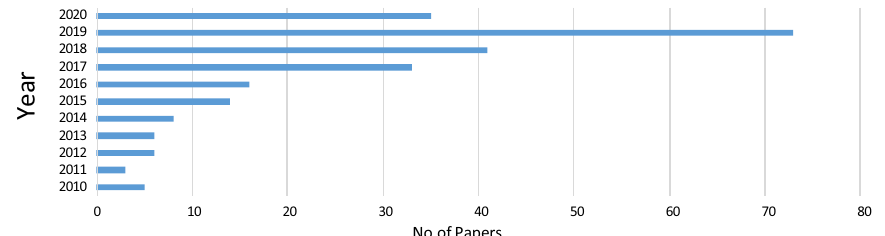
Fig. 9 The trend of selected published articles in agriculture between 2010 and